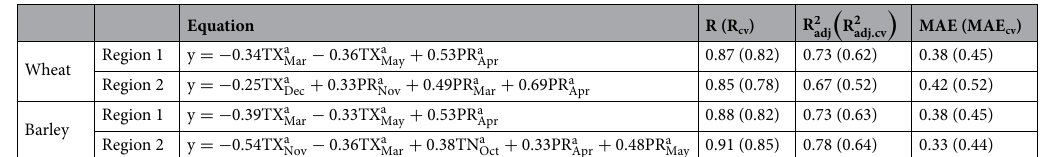
Table 1. Summary of linear models obtained through stepwise regression for wheat and barley yields (denoted y in the equations) located in Region 1 and Region 2. The validation metrics considered are the 2 Pearson correlation R, R adjusted to the number of predictors in the regression model R absolute error (MAE) with and without leave-one out cross-validation (cv). The predictors are symbolized as PR a , TX a , and TN a for precipitation, minimum and maximum temperature monthly standardized anomalies, respectively. The month in the subscript represents the month of the